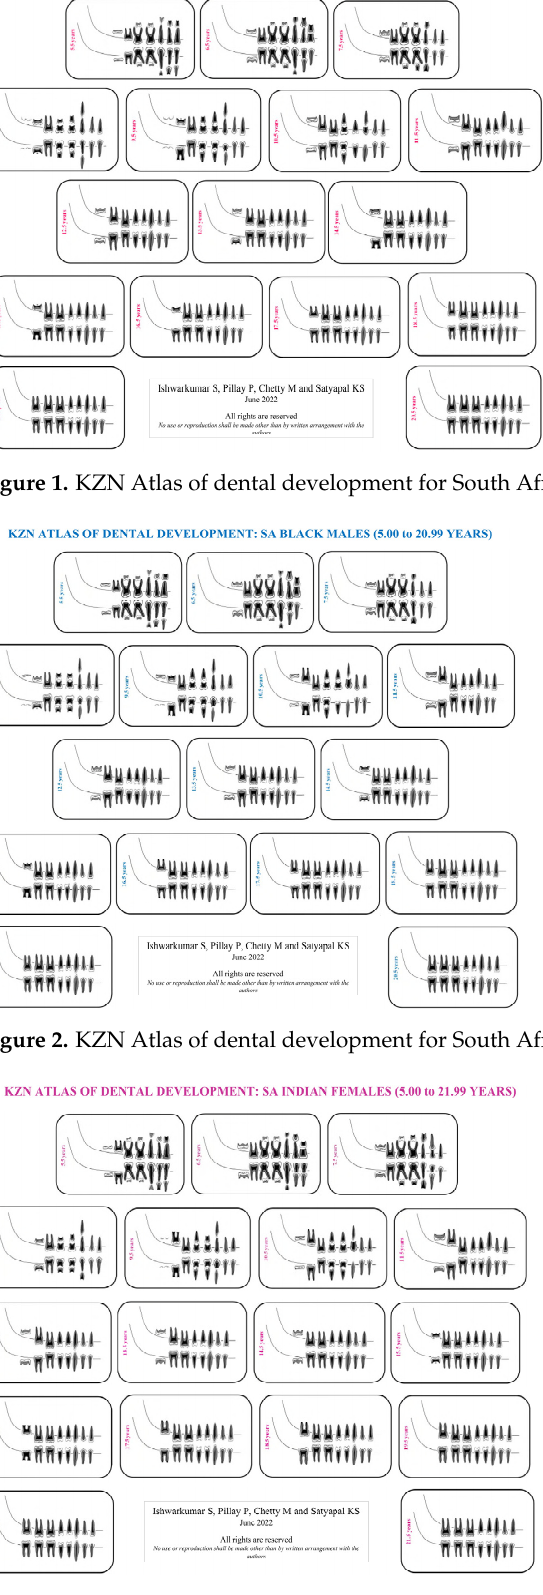
Figure 3. KZN Atlas of dental development for South African Indian females.